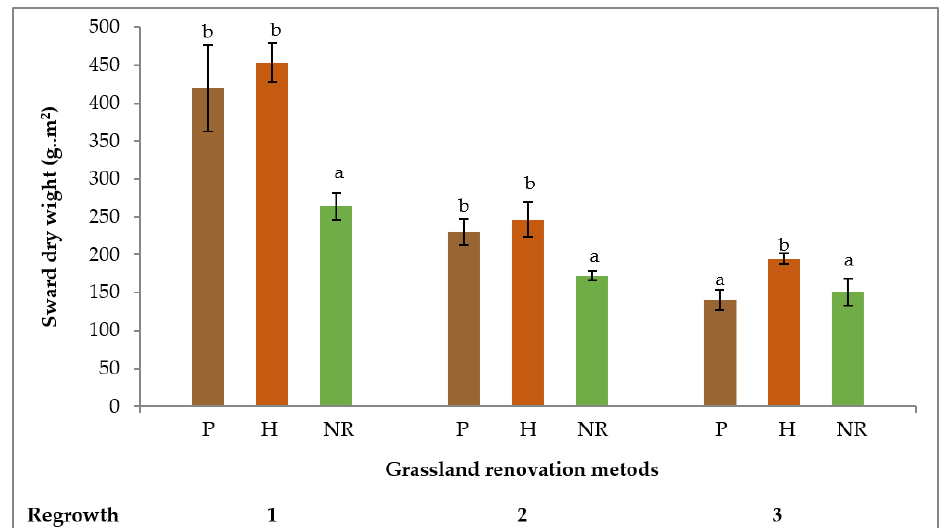
Figure 2. Three-year averages of dry biomass weight by grassland renovation method and by regrowth. P, ploughing; H, harrowing; NR, non-renovated (control treatment). In regrowth, the same letter above a column means no significant difference between the means.